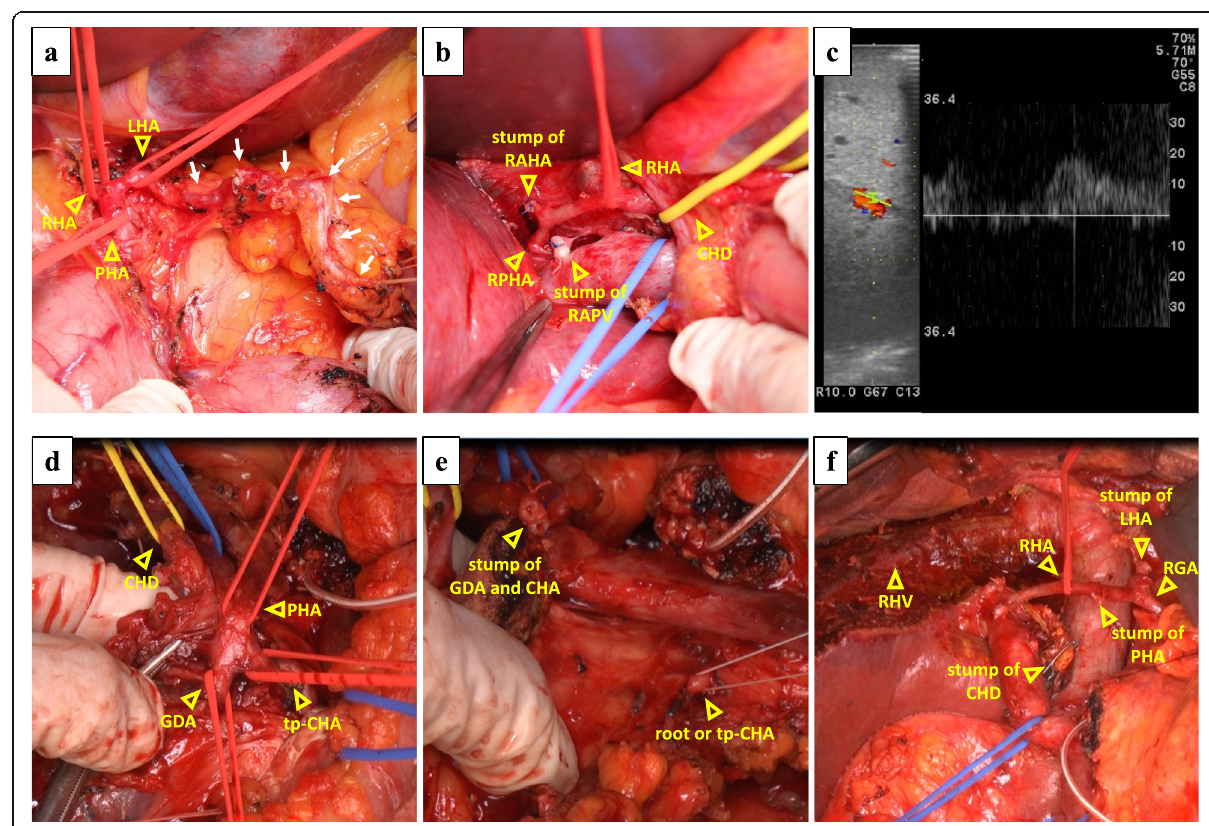
Fig. 3 a The gastric arterial arcade (white arrows) was exposed, and the LHA, RHA, and PHA were taped. b The RPHA was supraportal, and the RAHA, RAPV, and right anterior portal vein were divided. CHD common hepatic duct. c The hepatic arterial signal under PHA clamping was confirmed. d The specimen was left connected by only the PHA, CHA, and CHD. e We divided the PHA, GDA, and root of tp-CHA. f An image was obtained after the specimen was removed. RHV right hepatic vein